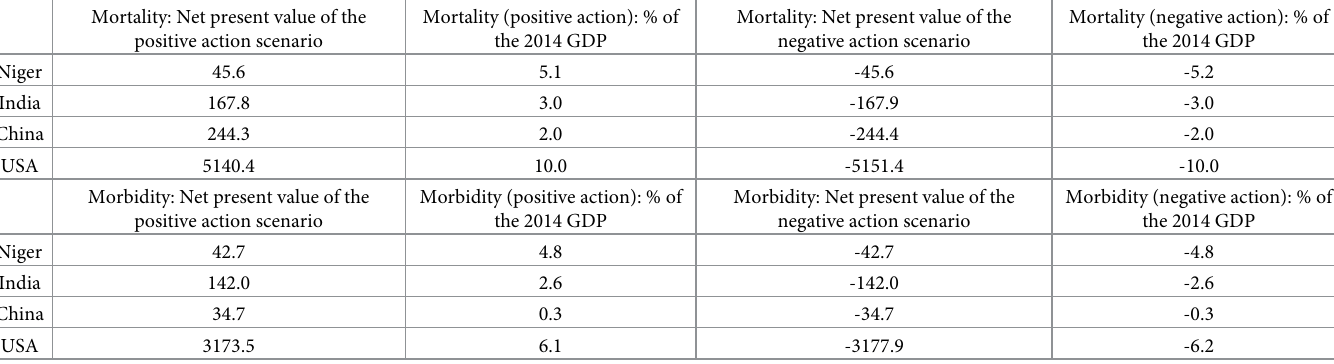
Table 5. GDP per capita gains due to a decrease/increase in mortality (morbidity) between 2015 and 2039 1 p.p. bigger than that between 1990 and 2014. Mortality: Net present value of the positive action